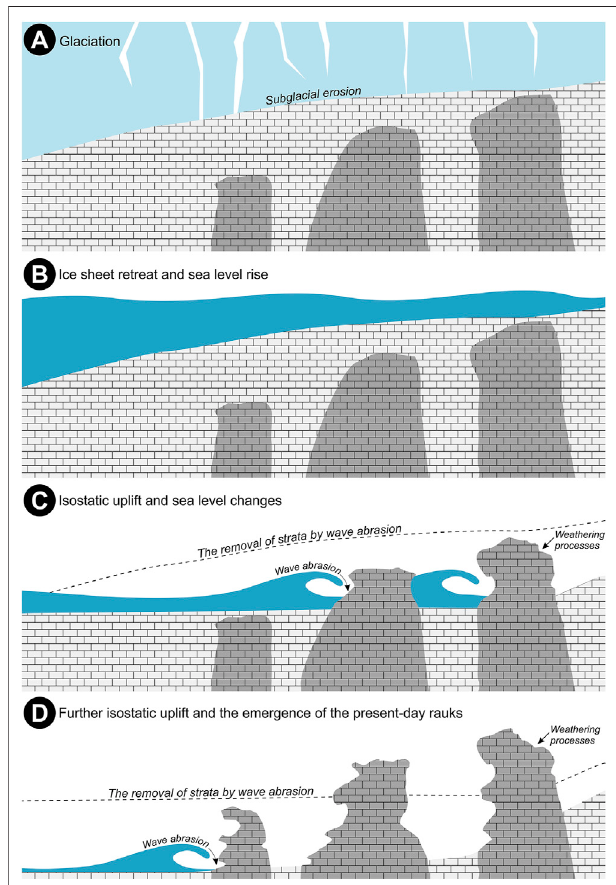
FIGURE 8 | The conceptual model of rauk fi eld development along the coast of Gotland. (A) The Gotland region is overridden by an ice sheet during the last glaciation. Limestone bedrock is exposed to subglacial erosion. (B) Glacially modi fi ed bedrock is exposed to ice. Weaker limestones are cracked and shattered by glacial exaration and/or shattered by periglacial/ proglacial conditions and prepared for subsequent abrasion by waves. (C) Baltic Sea in a complex cycle of transgressions and regressions erodes and removes weaker limestone strata from around the rauk. Abrasion forms sea stacks and produces the notches. (D) Glacioisostatic uplift separates sea stacks from the sea, making them residual landforms, no longer subject to waveabrasion.Atpresent,therauksaresubjecttolimitedphysicalweathering (e.g., frost action and chemical weathering), yet their microrelief maintains a marine